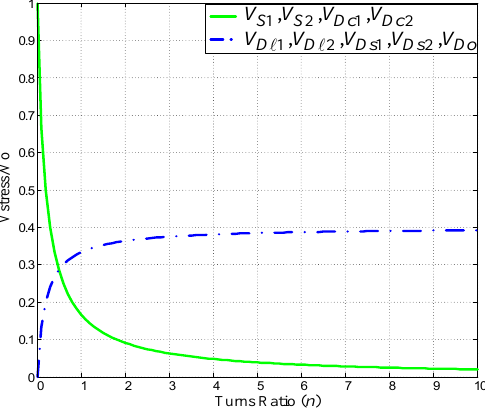
Figure 6. Normalized voltage stresses on semiconductor devices.